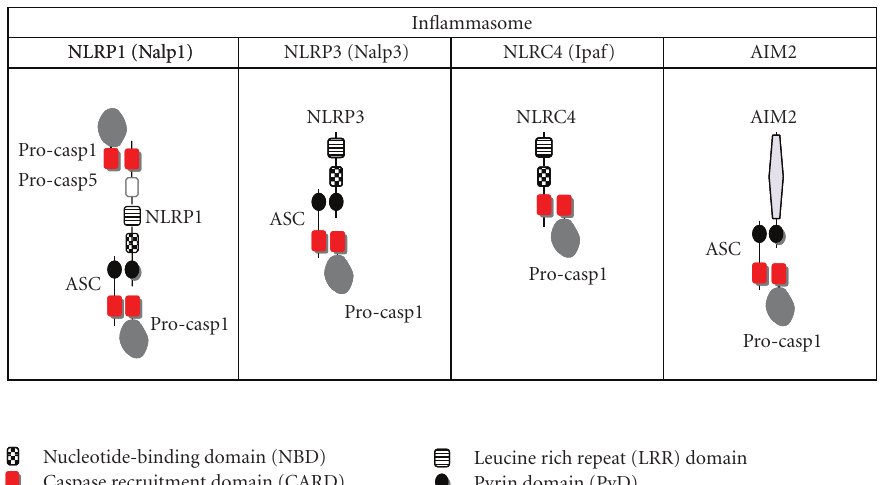
Figure 1: Inflammasome constituents. There have been reported at least four types of inflammasomes, NLRP1 (Nalp1), NLRP3 (Nalp3), NLRC4 (Ipaf), and AIM2 inflammasomes. NLR is subdivided into two groups, PYD-possessing group, namely, NLRP and PYD-lacking group NLRC. After exposure of cells to the corresponding stimuli, these NLRs and AIM2 are believed to be self-oligomerized. As it contains CARD at an N-terminus and PYD at a C-terminus, self-oligomerized NLRP1 can recruit procaspase (casp)-1 and procaspase-5 by action of its CARD and also assembly procaspase-1 with help from ASC that possesses both PYD and CARD. Self-oligomerized NLRP3 recruits procaspase-1 by interposing ASC between them. In contrast, self-oligomerized NLRC4 recruits procaspase-1 by directly interacting CARD of procaspase-1 with its CARD. AIM2, belonging a di ff erent protein family, is also believed to be self-oligomerized after recognition of double- stranded DNA and recruits procaspase-1 with help from ASC. NLR, Nod-like receptor; CARD, caspase recruitment domain; PYD, pyrin domain.